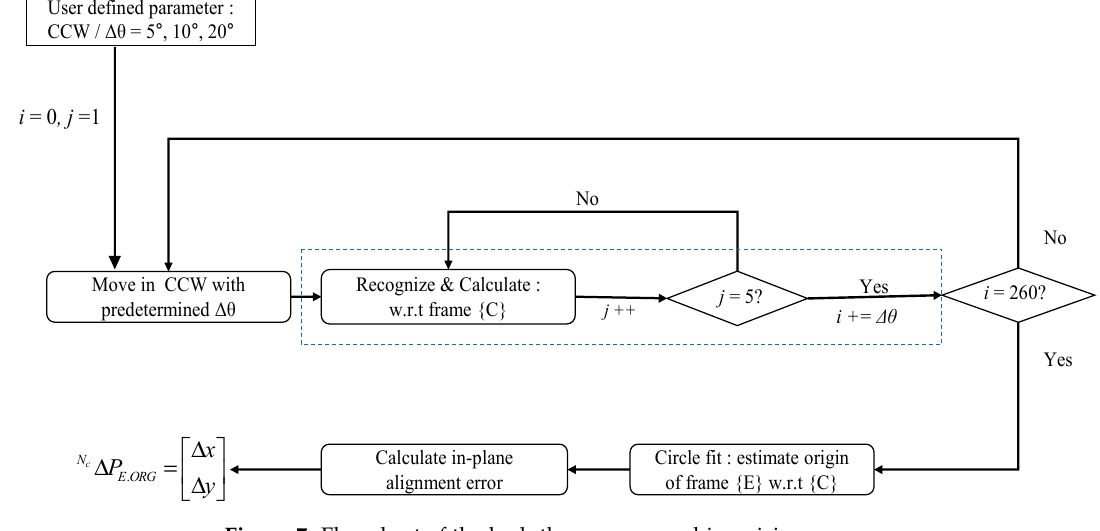
Figure 7. Flowchart of the look-then-move machine-vision process.